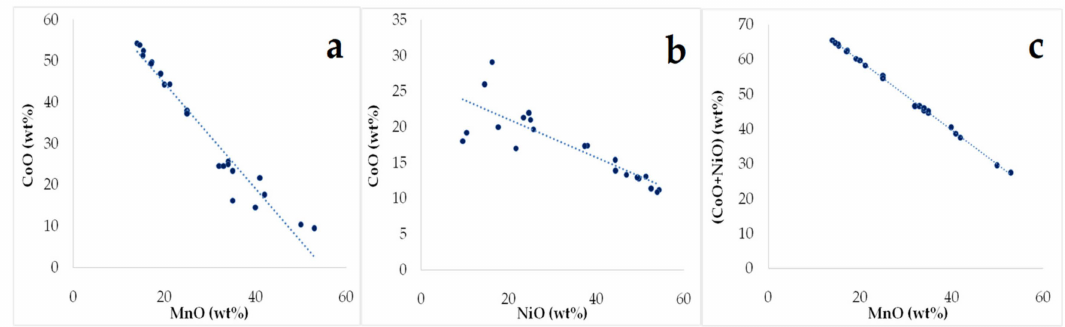
Figure 7. Plots CoO versus MnO, NiO, ( a , b ) and (CoO + NiO) versus MnO ( c ). Data from Table